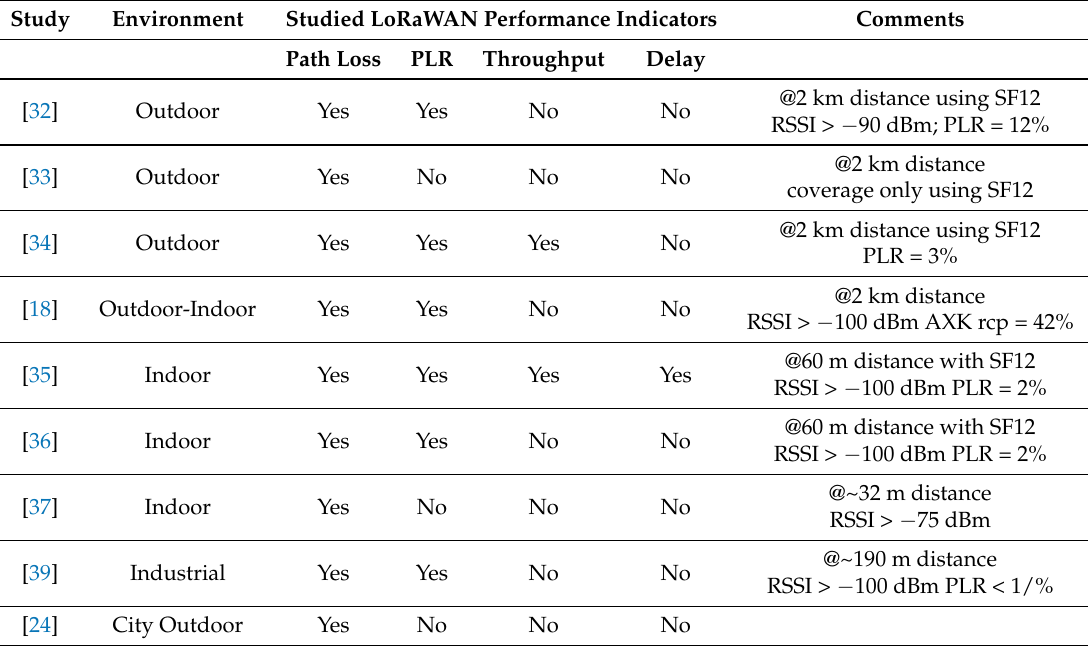
Table 3. LoRaWAN deployed